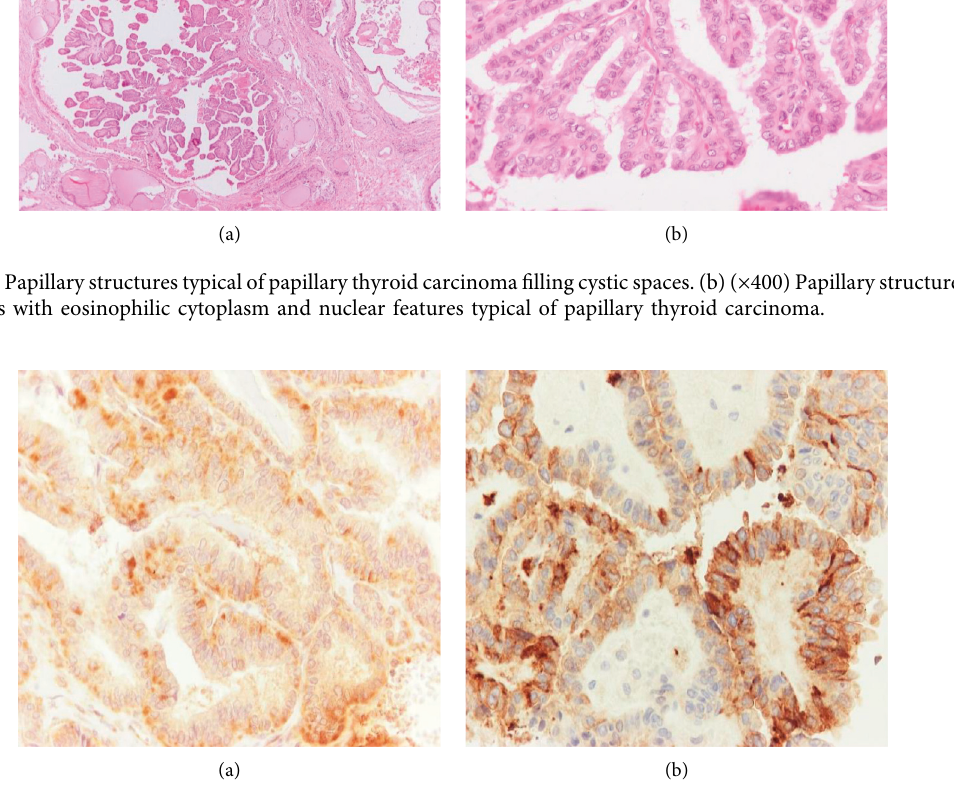
Figure 2: (a) ( × 400) Immunohistochemical stain for IL-6 proved to be positive in cancer cells. (b) ( × 400) A small proportion of cancer cells displayed immunoreactivity for